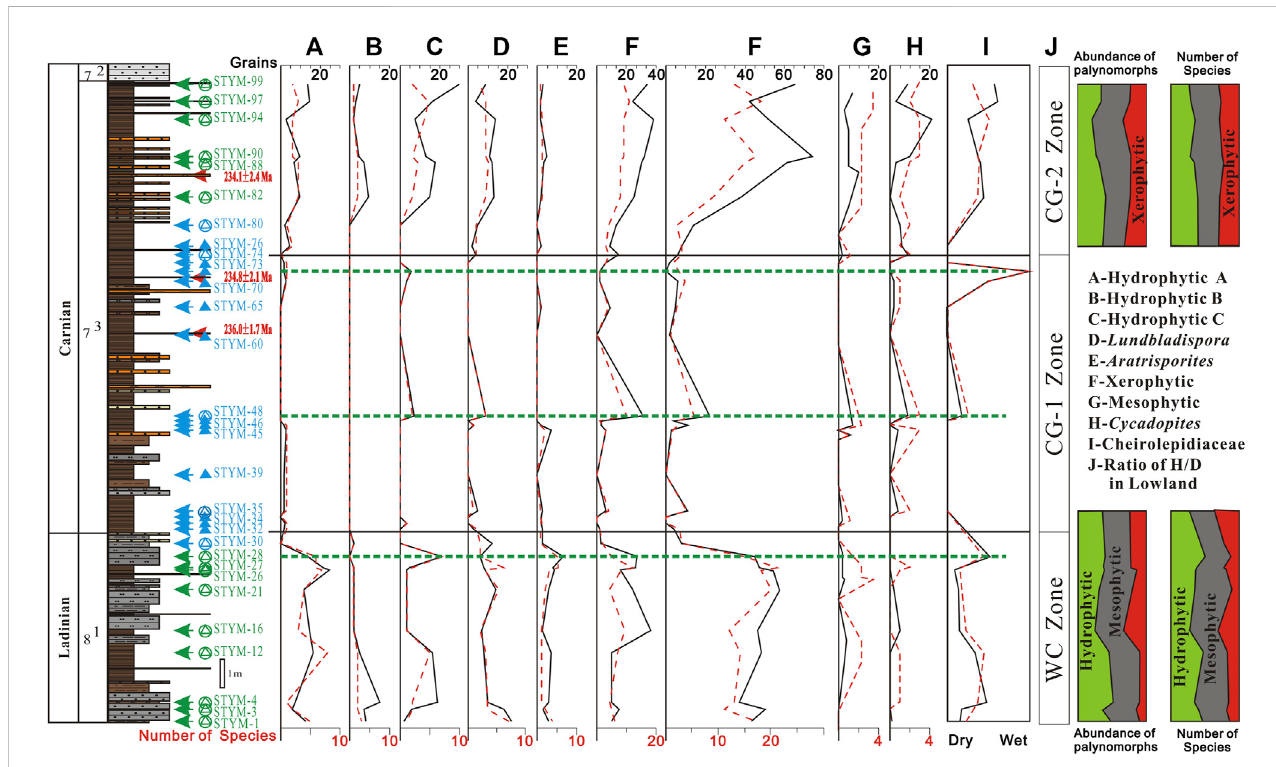
FIGURE 8 Reconstructed humidity based on diversity and abundance of palyno fl oras at Yunmeng pro fi le, Ordos Basin,